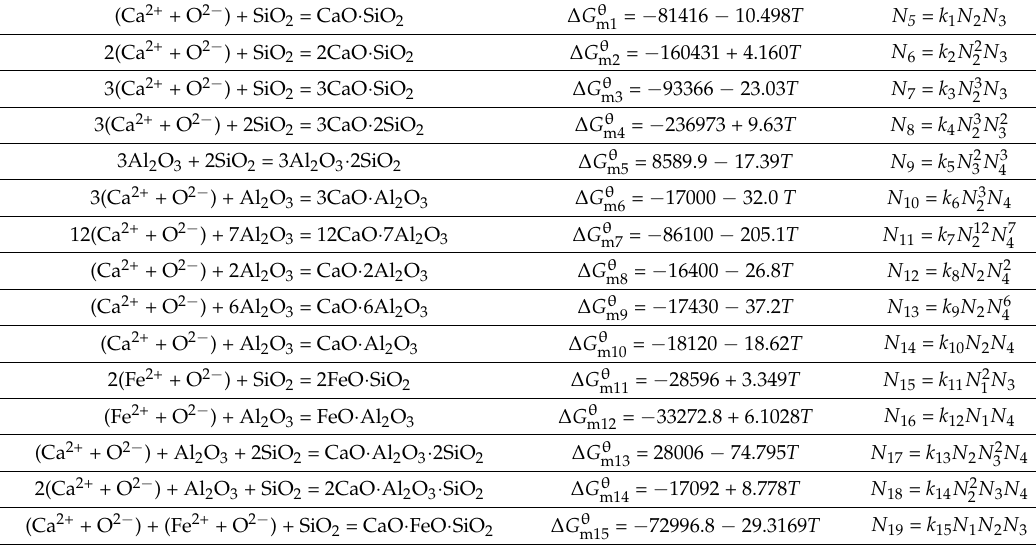
Table 2. Chemical equilibria of structural